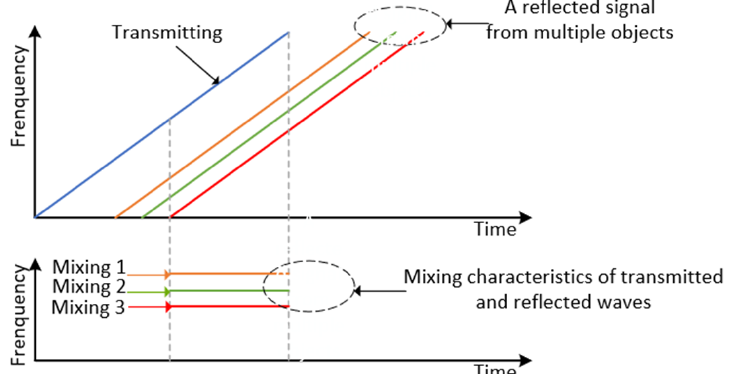
Figure 3. FMCW wave diagram.